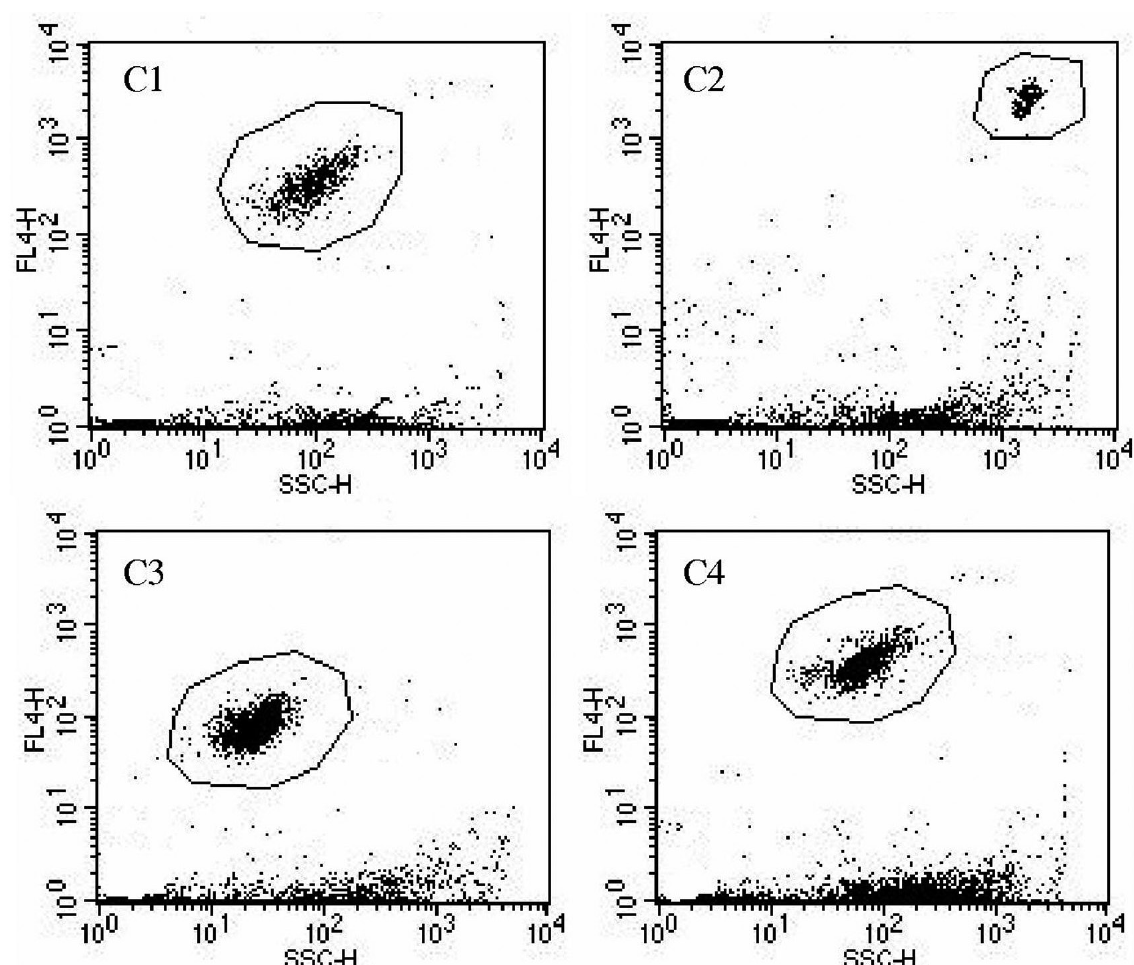
Fig . 3. – Flow cytometry dot plots of cell size vs phycocyanin signals of isolated coastal cyanobacteria population